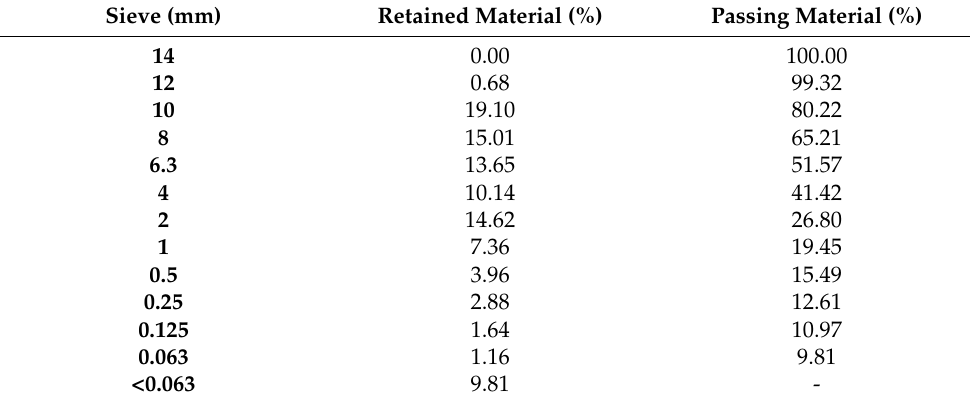
Figure 2. SMA grading distribution. Table 2. SMA gradation.